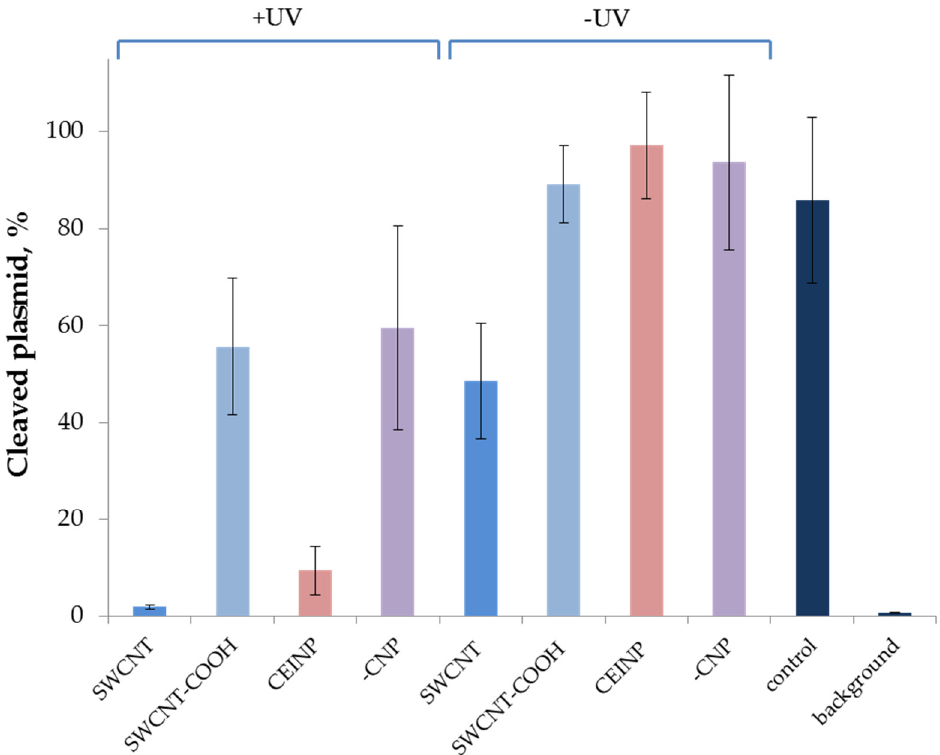
Figure 6. DNA plasmid cleavage by nanoCRISPR/Cas9 systems with CNP-immobilized (SWCNT, SWCNT-COOH, CEINP) with or without UV irradiation. crRNA immobilized on the surface using the PC-DNA (B30_PL). The plasmid cleavage was performed with and without UV irradiation. “Control” corresponds to the DNA cleavage by crRNA/tracrRNA/Cas9 in the absence of PC-DNA and CNPs. “Background” corresponds to the cleavage extent in the absence of nuclease, “-CNP”-to the non-immobilized duplex of PC-DNA (B30_PL) with crRNA. Conditions: crRNA immobilized through of B30_PL, the temperature of cleavage reaction was 37 °C, irradiation 30 min at 365 nm.